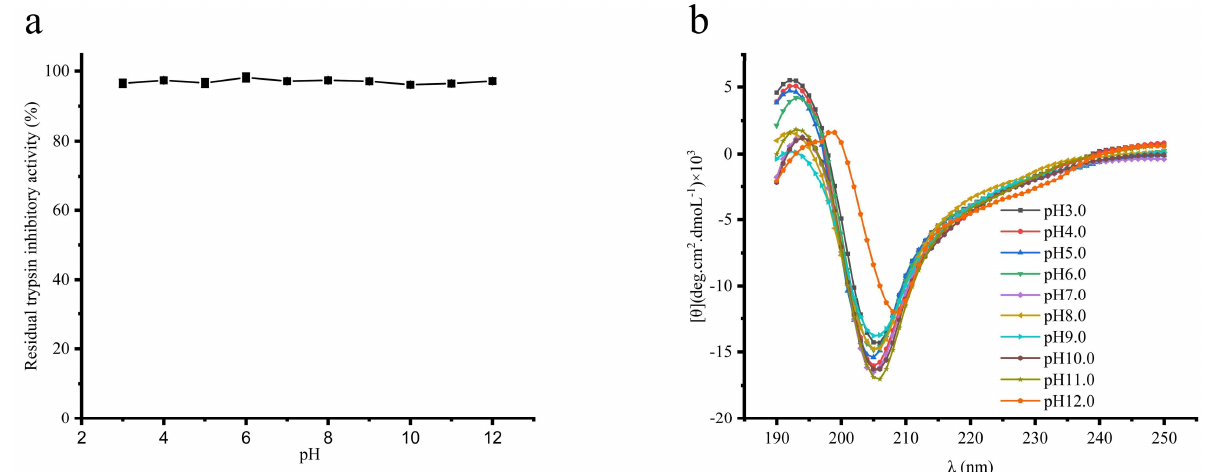
Figure 7. The effect of pH on the activity of STI ( a ). The circular dichroism spectra of STI ( b ). The data of residual trypsin activity in each pH are not significantly different. Residual trypsin inhibitory activity is expressed as the percentage of trypsin inhibitory activity after the treatment accounting for trypsin inhibitory activity of the untreated STI (pH 6.7).